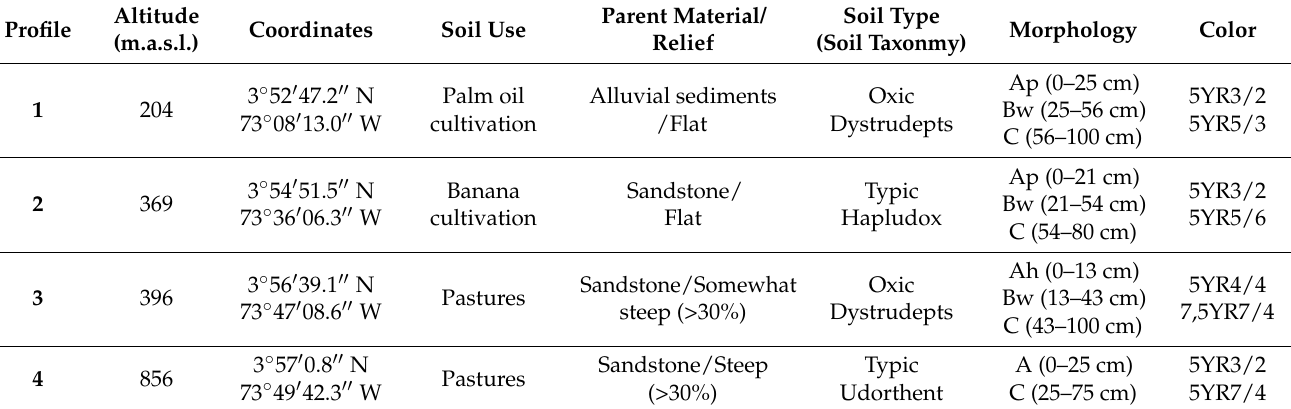
Table 2. Essential macromorphological and diagnostic features of the studied soil